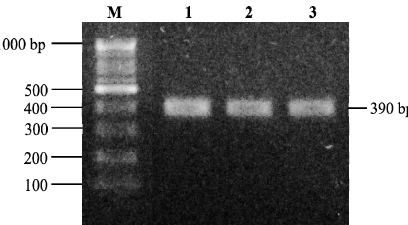
Figure 5. Electrophoresis of PCR products amplified for a gene encoding MCO (390 bp) in L. brevis . Lanes M: 1000 bp DNA ladder, 1: L. brevis JCM 1170, 2: L. brevis PK08, 3: L. brevis PK11. The MCO gene was not detected in L. helveticus KCCM 40989, L. plantarum KCTC 3108, L. sakei KCCM 43213, L. casei KCCM 12452, L. paracasei KCTC 3510, L. fermentum KCTC 3112, L. buchneri KCTC 5064, Leu. mesenteroides KCTC 3505, and Leu. citreum KCCM 12030.